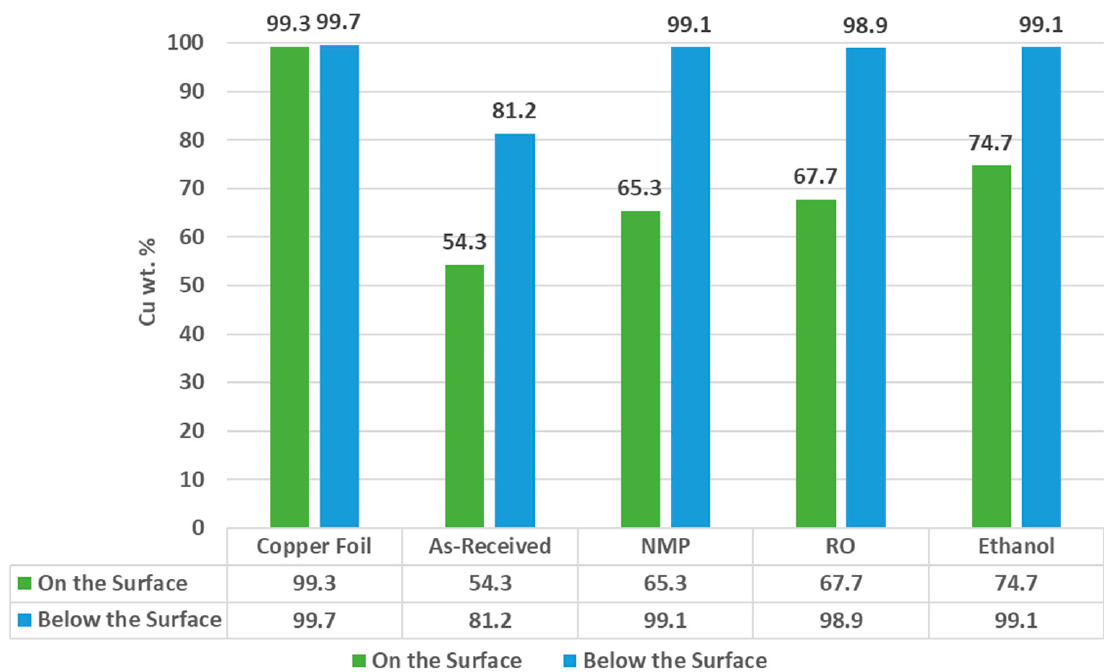
Figure 6. The weight percentage of Cu on and below the surface of a LIB-graded fresh Cu foil, recycled Cu as-received from spent batteries, and recycled Cu after washing with NMP, RO, and ethanol.